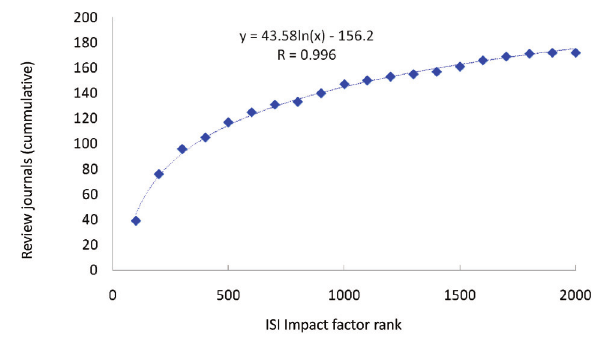
Figure 6 - Cummulative distribution of Review Journals in the top third of the entire 2008 Science Citation Edition of JCR (p <